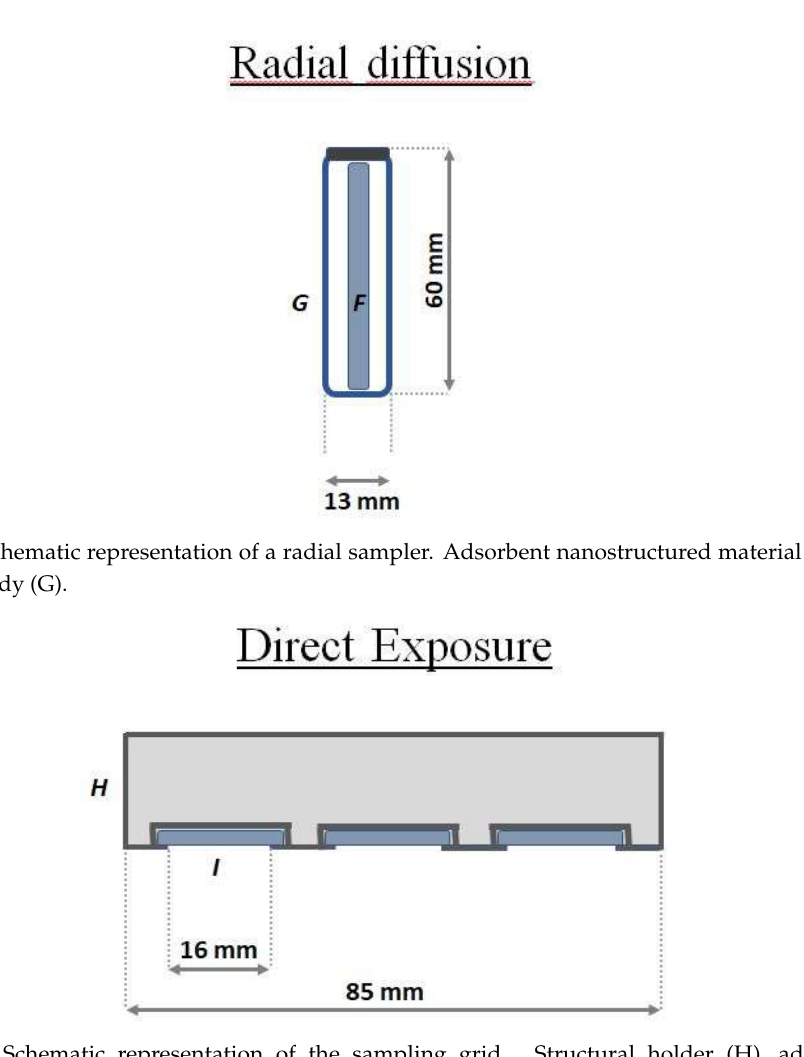
Figure 3. Schematic representation of the sampling grid. Structural holder (H), adsorbent nanostructured material (I).